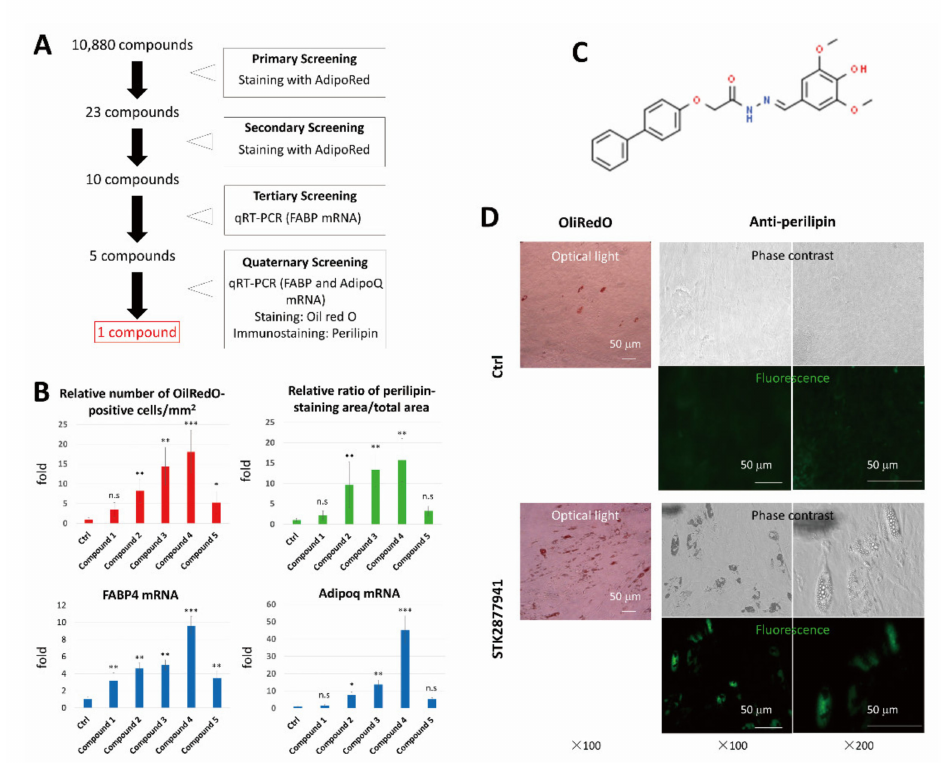
Figure 1. Identification of a small molecule that induces an adipocyte phenotype in human dermal fibroblasts (HDFs). ( A ) Strategy to identify compounds that induced conversion of HDFs into adipocytes. ( B ) In tertiary screening, HDFs were cultured for 14 days with the indicated compounds at 10 µ M or without a compound as a control. Cells were stained with OilRed O to determine the number of OilRed O-positive cells/mm 2 (upper left) and the ratio of perilipin-stained area/total area (upper right). RNA was subjected to real-time RT-PCR analysis to evaluate the mRNA levels of FABP4 and AdipoQ (lower). In the lower graphs, data are shown as mean ± SD normalized with respect to the β -actin mRNA level in each sample. The relative value to the control group (set to 1.0) was calculated ( n = 6, for each group). ( C ) Structure of STK287794. ( D ) HDFs were cultured with or without 10 µ M STK287794 for 14 days. Cells were stained with OilRed O or anti-perilipin antibody, followed by observation under a fluorescence microscope (middle and right). * p < 0.05, ** p < 0.01 and *** p < 0.001 vs. control group. ns: not